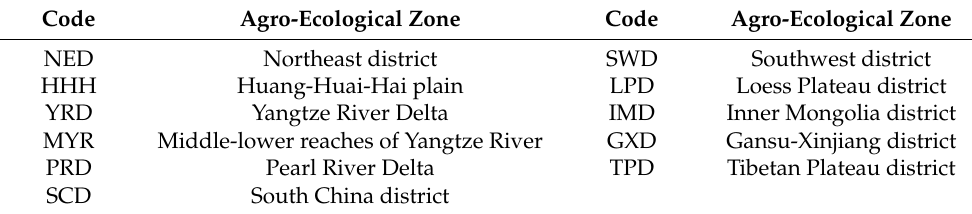
Table 1. Summary of 11 agro-ecological zones in